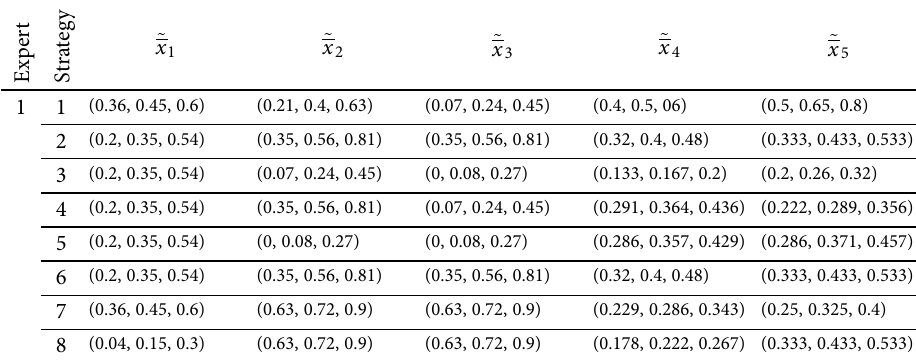
Table 6. Individual weighted normalised decision